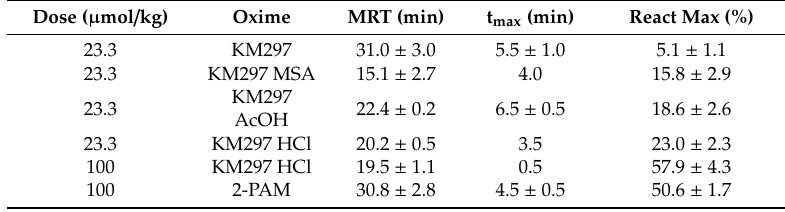
Figure 3. The reactivability of VX-inhibited hAChE by KM297 as free base and salts, and 2-PAM in mice plasma. (a) The same dose of 23.3 µ mol / kg of KM297 free base and salts: acetate (AcOH), chlorhydrate (HCl) and methylsulfonate (MSA) was administered intraperitoneally to mice ( n = 8). (b) The same dose of 100 µ mol / kg of KM297 HCl and 2-PAM was administered intraperitoneally to mice ( n = 8–10). Blood samples were drawn at various time points (0, 2, 5, 10, 15, 30, 60 and 180 min) after treatment, and the levels of reactivation of VX-inhibited hAChE were determined. Values are presented as percentages of maximum reactivation and points are means ± SEM. Fitting was performed on GraphPad Prism software. Table 3. MRT: mean residence time, t max and React max respectively x and y coordinates of the peak of reactivability of VX-inhibited hAChE by KM297 as free base and salts, and 2-PAM in mice plasma presented in Figure